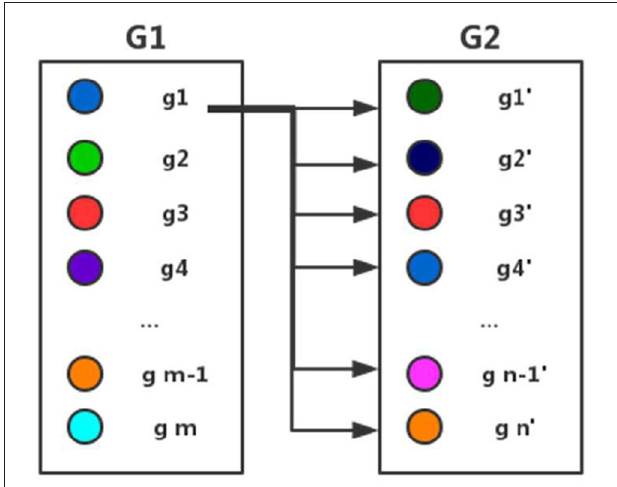
FIGURE 2 | Computing the similarity between two gene